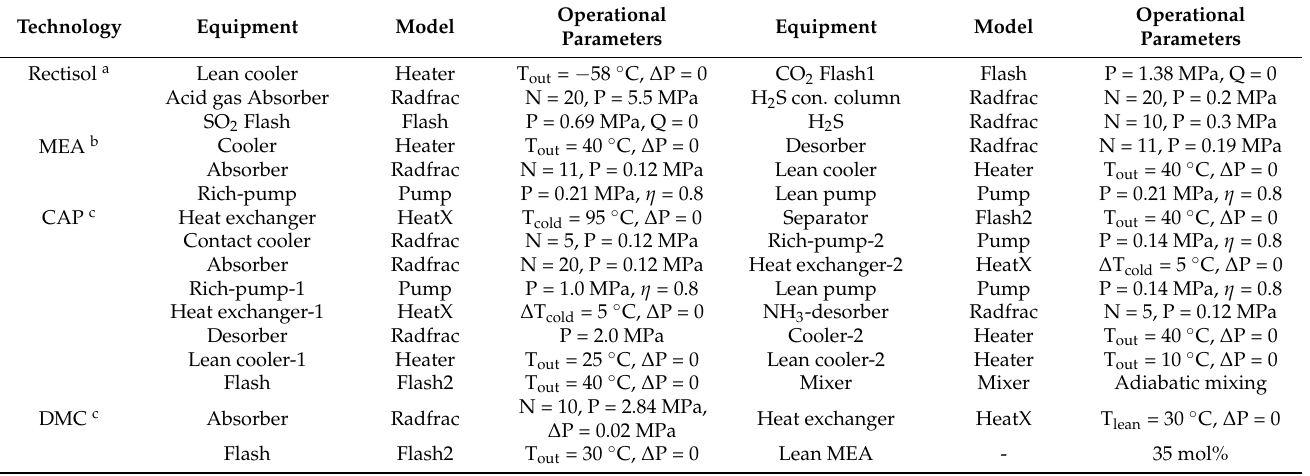
Table 1. Key parameters for the simulation of four CO 2 capture